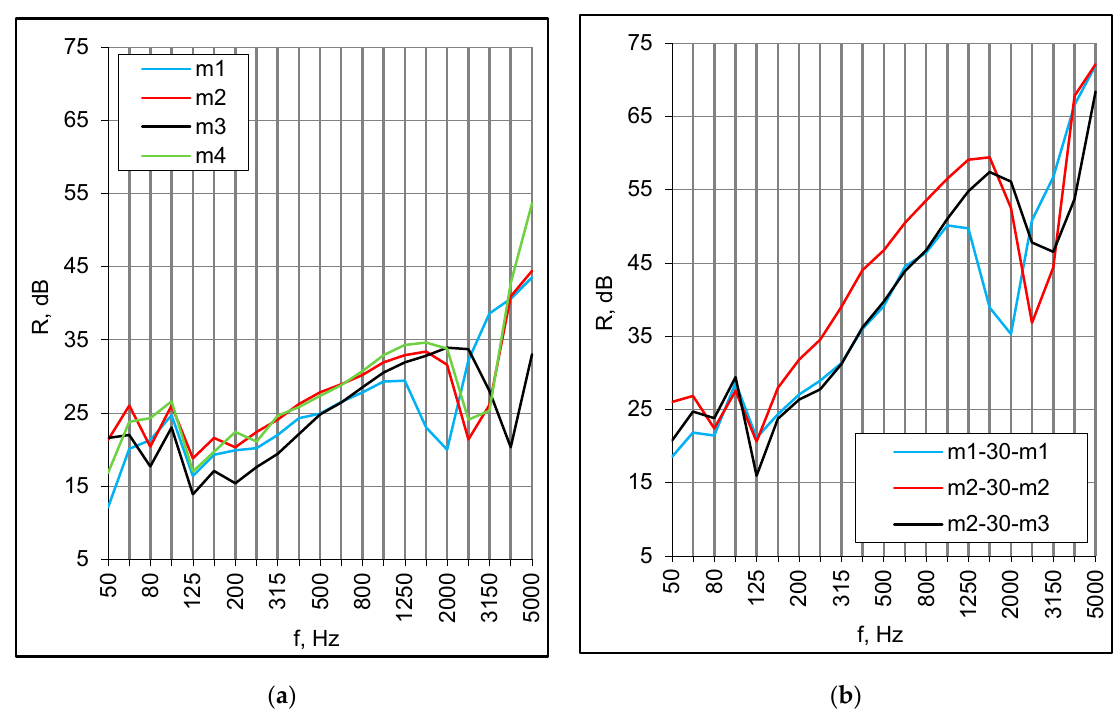
Figure 3. ( a ) Sound reduction index of standalone panels, small samples; ( b ) Sound reduction index of double set-ups with 30 mm empty cavity, small samples.